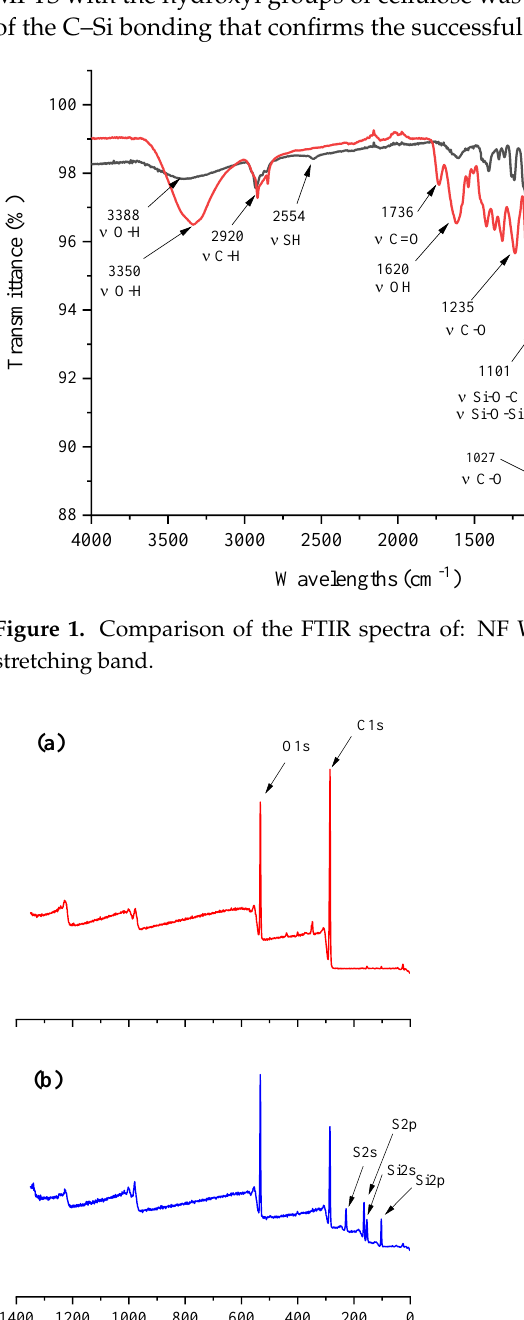
Figure 2. XPS survey of WJF before ( a ) and after MPTS treatment ( b ).